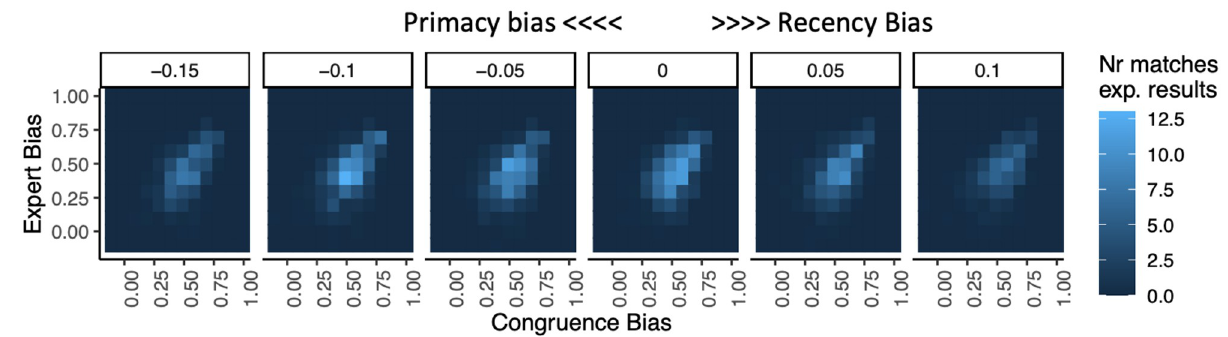
Fig 6. CongruentBias and ExpertBias parameter spaces for different values of PrimacyBias , showing the number of times (out of 5000) that the simulation results (approximately) matched the experimental results, for each parameter value combination. Lighter colour represents more matches, indicating the parameter values that best fit the experimental results. Only positive values of CongruenceBias and ExpertBias are shown, as there were no matches in negative values (i.e., values favouring the incongruent and peer’s variants, respectively).